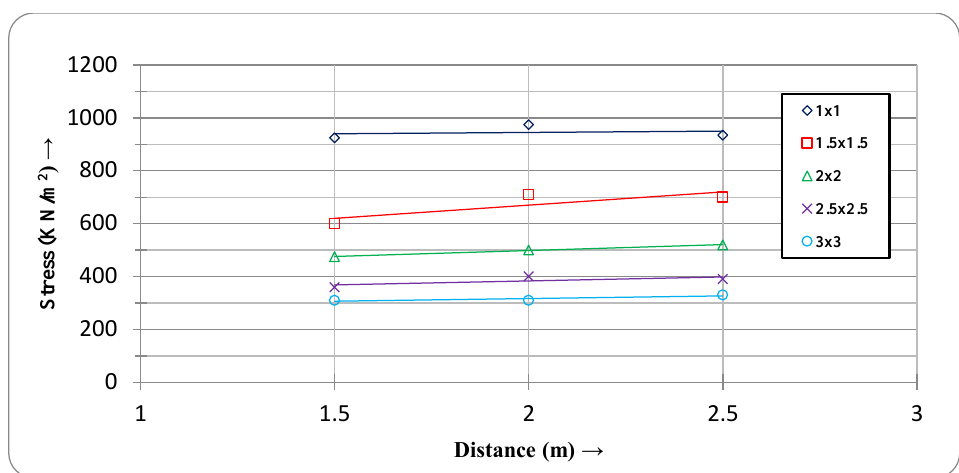
Fig. 21. Stress vs. Distance graph for different footing size (settlement 50 mm fixed). Fig. 21 represents the combined graph of Stress vs. Distance under allowable settlement of 50mm for different dimensions. The graph lines representing different dimensions are found as flat indicating less stress deviation in varying spacing between two adjacent